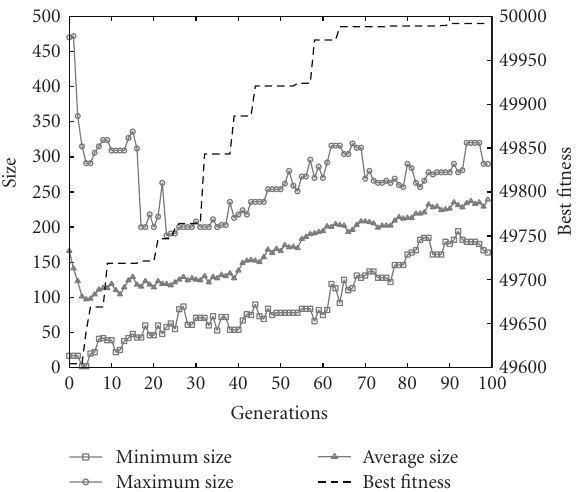
Figure 5: Symbolic regression Experiment 3: chromosome sizes.